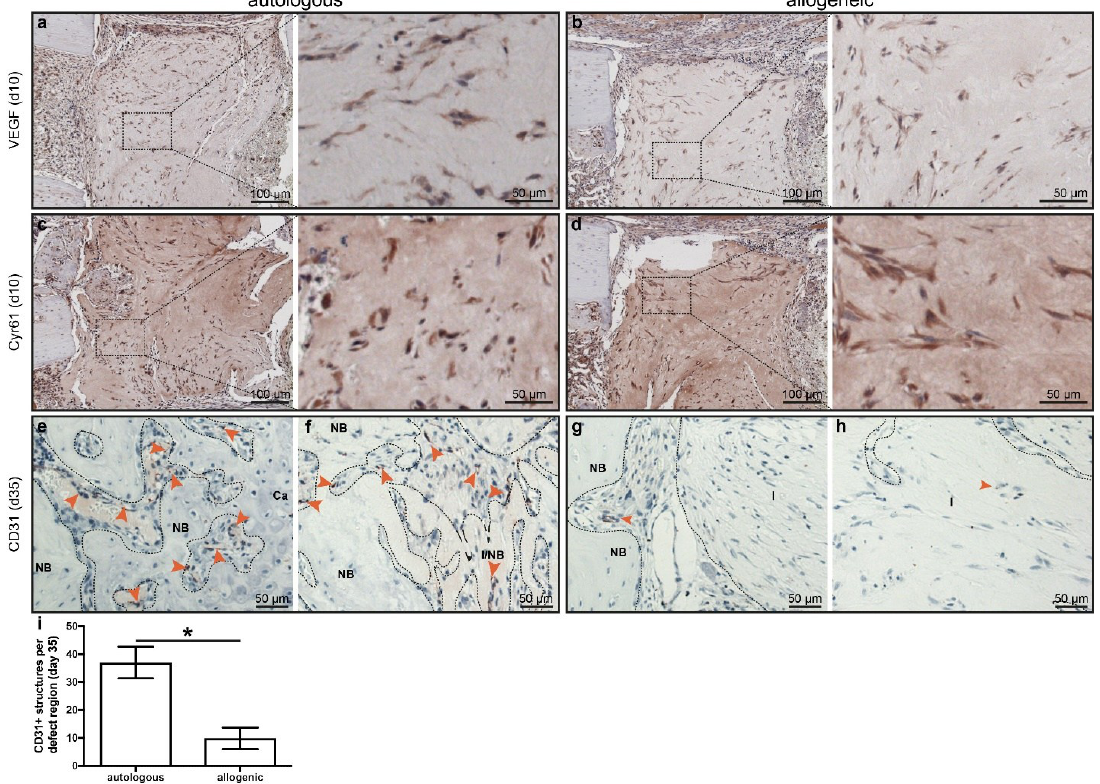
Figure 4. Expression of angiogenic markers. ( a , b ) Staining of vascular endothelial growth factor (VEGF) on day 10 in ( a ) mice with autologous human mesenchymal stem cells (hMSC) treatment and ( b ) mice with allogeneic hMSC treatment. ( c , d ) Staining for Cyr61 on day 10 in mice with ( c ) autologous hMSC treatment and ( d ) allogeneic hMSC treatment. ( e – h ) Staining of CD31 (PECAM) on day 35 in mice with ( e , f ) autologous hMSC treatment and ( g , h ) allogeneic hMSC treatment. ( e ) and ( g ) represent the edge of the implant while ( f , k ) represent the center of the implant. NB: new bone; Ca: cartilage, I: implant. Arrowheads indicate structures positive for CD31. ( i ) Quantification of CD31 staining. Dashed boxes indicate areas displayed in higher magnification. The data are presented as the mean ± SD, * p ≤ 0.05, autologous n = 2; allogeneic n = 6.